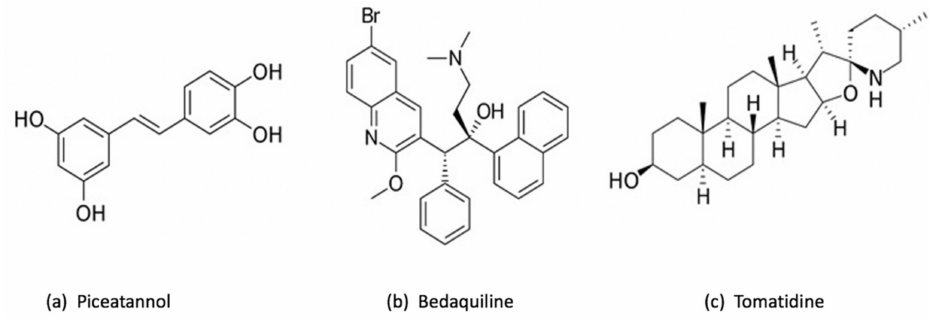
Figure 3. Chemical structure of 3 chemical inhibitors: ( a ) Piceatannol, ( b ) Bedaquiline and ( c ) Tomati- dine. Made with